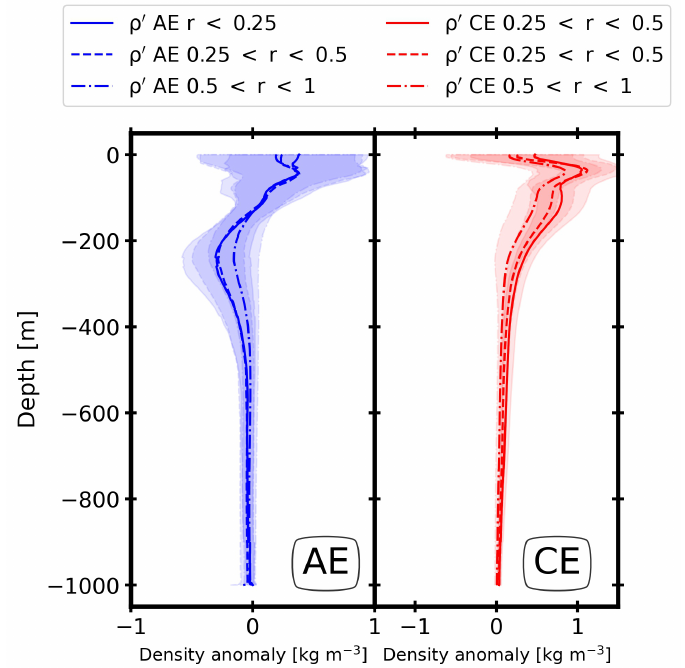
Figure 6. Density anomaly profiles, for both eddies of the RAH; AE/CE, several types of traits represent the different positions of the ARGO float detected inside the eddies; continuous line for profiles near the center r < 0.25; dashed line for further profiles 0.25 < r < 0.5; mixed line for the profiles near the edges 0.5 < r < 1.